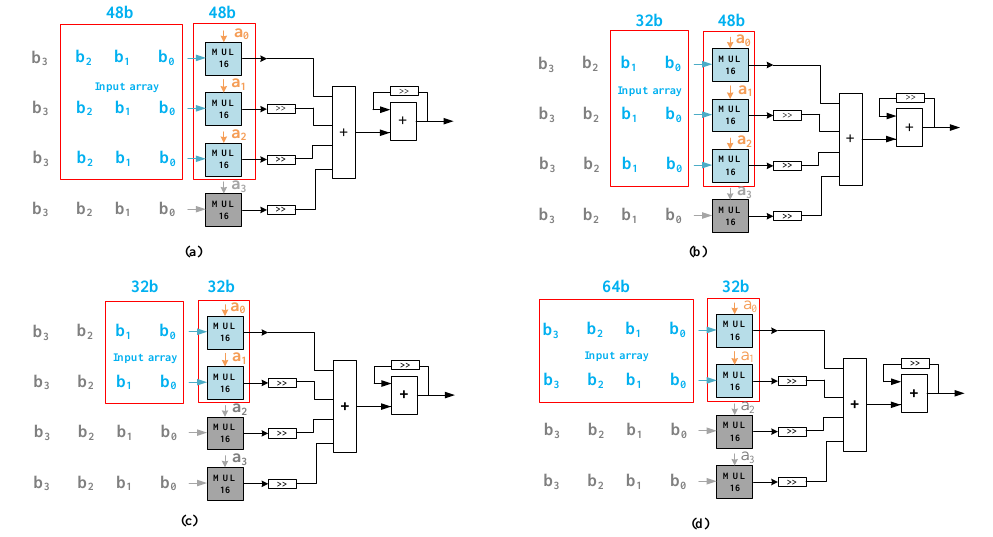
Figure 7. Four different multiply cases: ( a ) 48 × 48 bits; ( b ) 32 × 48 bits; ( c ) 32 × 32 bits; ( d ) 64 × 32